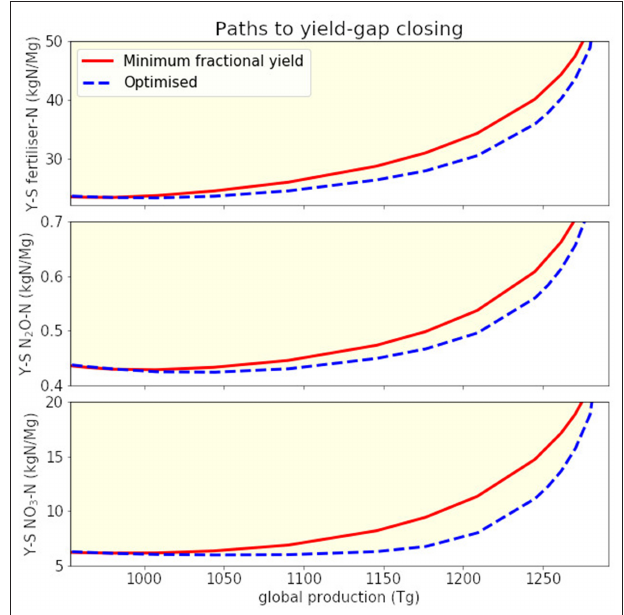
FIGURE 3 | Yield-gap closing following the “minimum fractional yield” scenario. (Top) The evolution of production, N-fertilizer usage, N 2 O emissions and NO − 3 leaching as the minimum fractional yield is increased. All values are given relative to current (2015) conditions. (Middle) The evolution of yield-scaled N-fertilizer usage, N 2 O emissions and NO − 3 leaching. (Bottom) The fraction of the total harvested area affected by yield-gap closing.